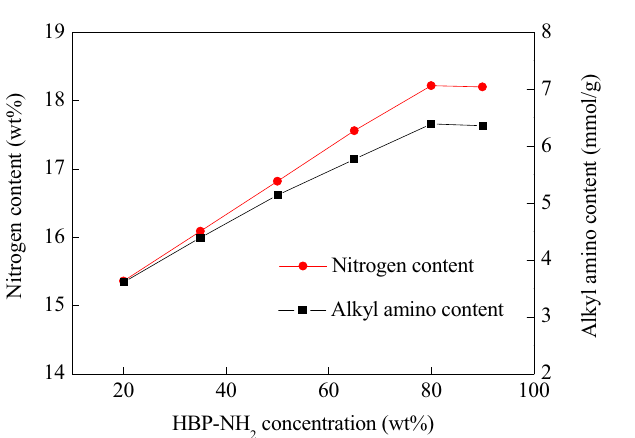
Figure 2. A possible structure of PP-AM-HBP-NH 2 .